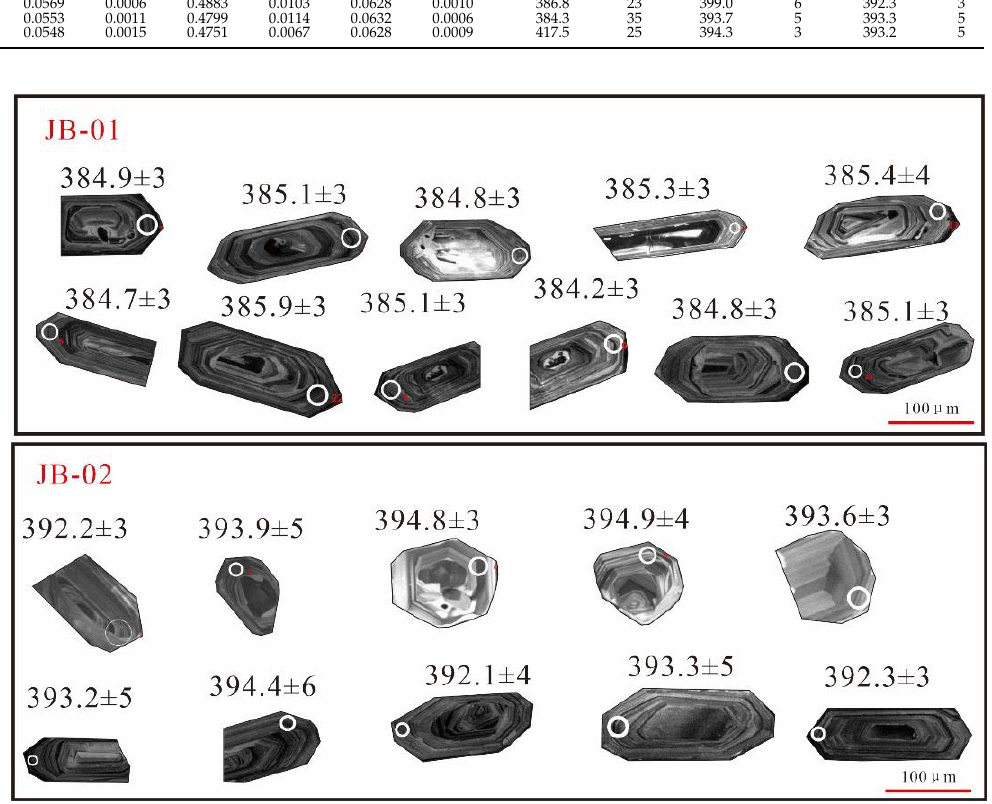
Figure 4. Typical cathodoluminescence images of typical zircon grains in the Jinba gold deposit. JB-01 is a granite dyke and JB-02 is a diorite dyke.